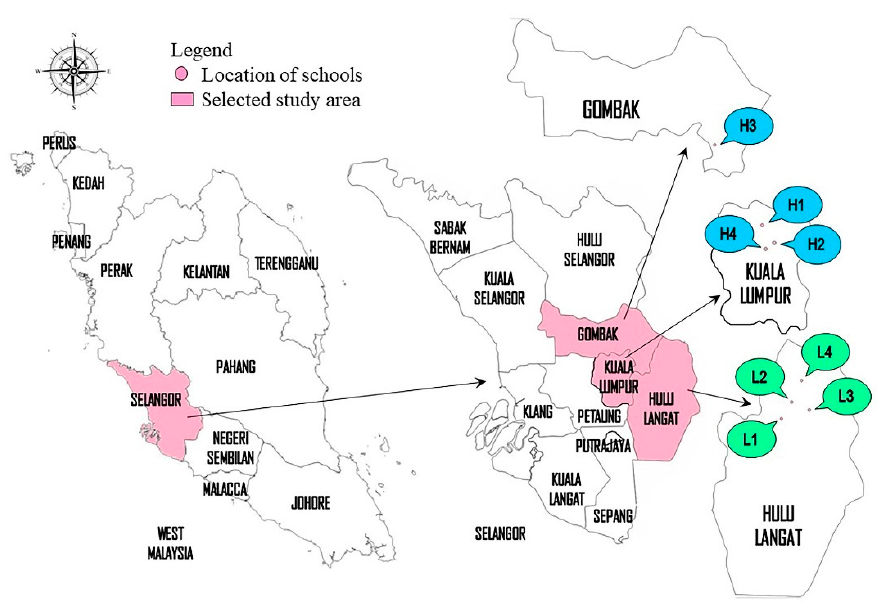
Figure 1. Locations of the selected primary schools.